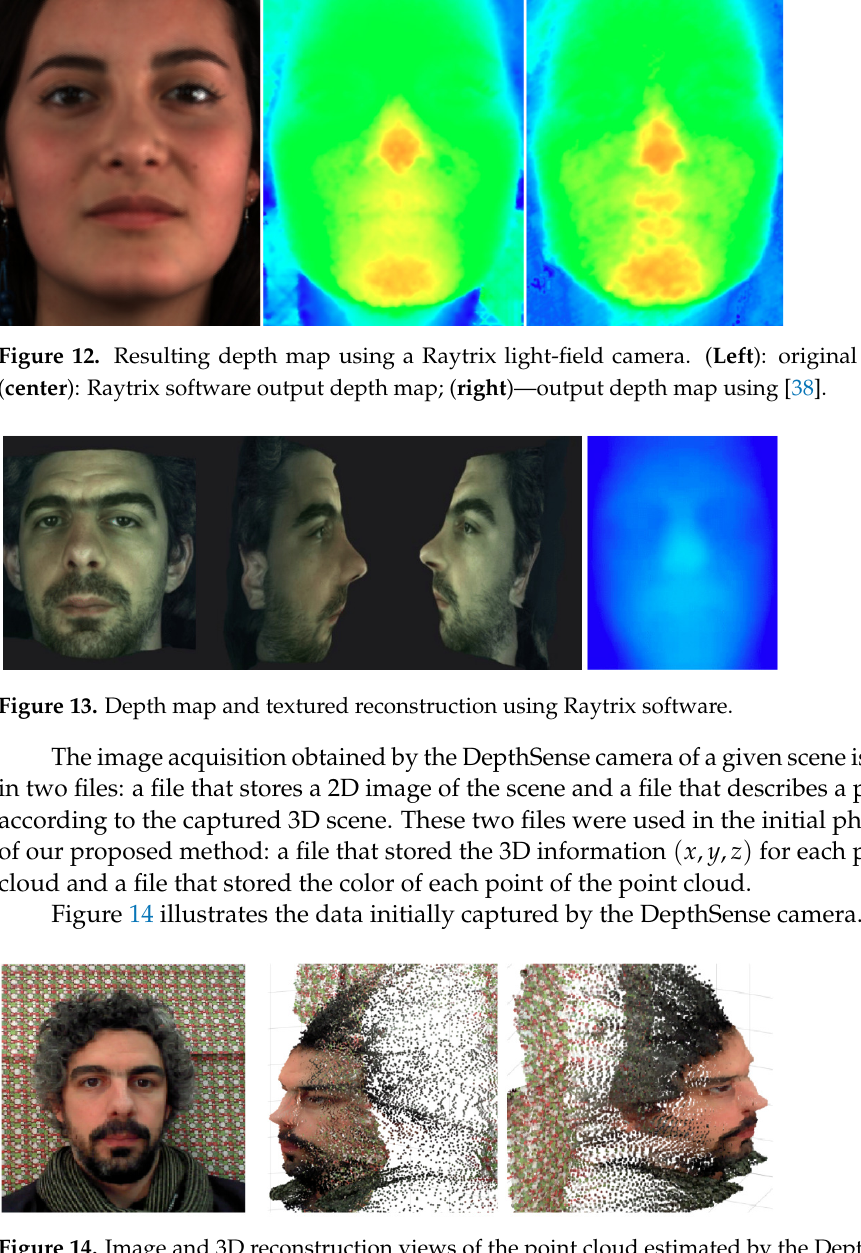
Figure 14. Image and 3D reconstruction views of the point cloud estimated by the DepthSense soft-